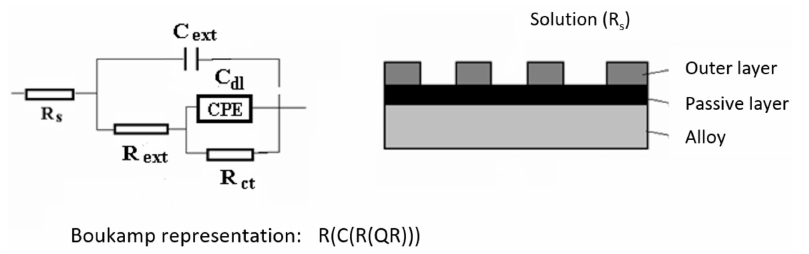
Figure 5. Equivalent circuit and physical surface model representation for samples immersed for 1 h and 30 days in wastewaters.